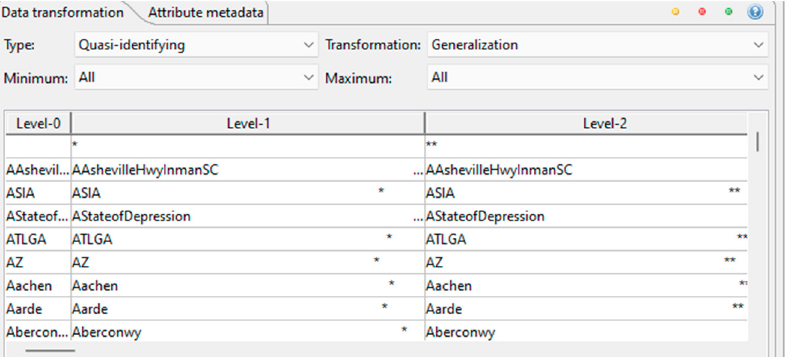
Figure 7. Hierarchy userlocation.